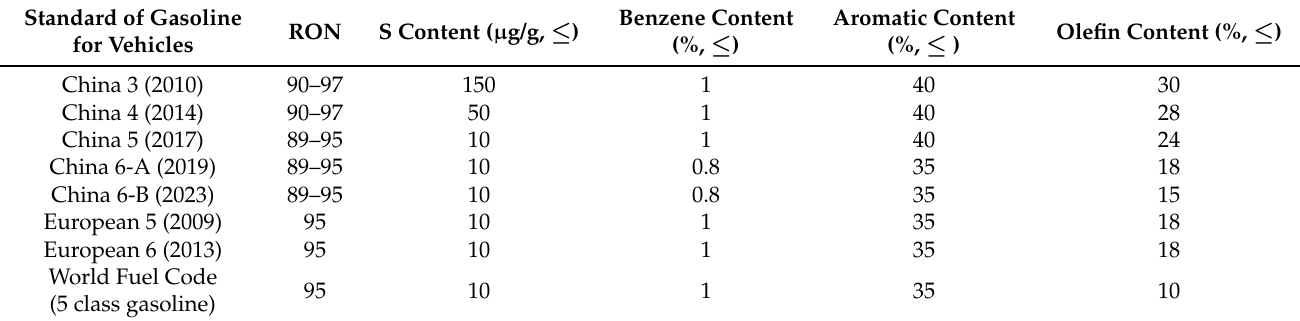
Table 1. European Union and China’s main specifications for automotive